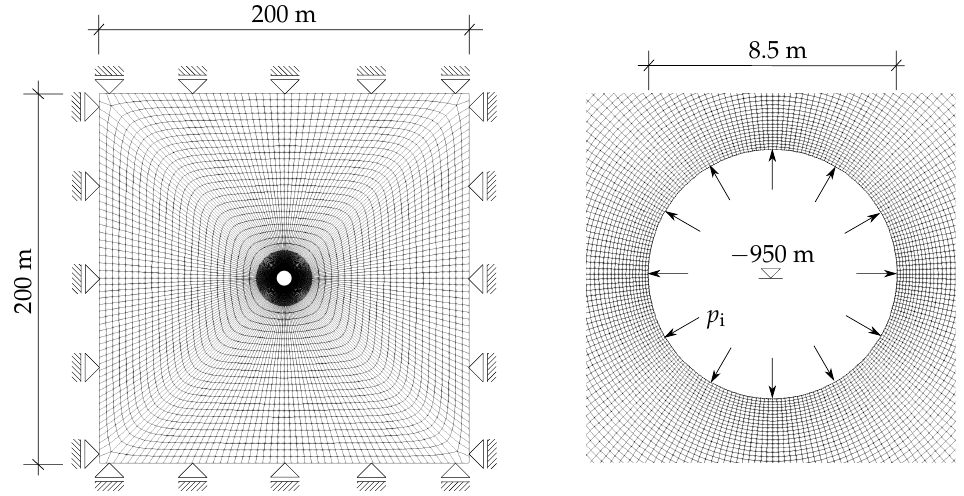
Figure 8. Illustration of the 2D finite element model of the tunnel excavation: full model (left) and detailed view of the FE - mesh in the vicinity of the circular tunnel (right).